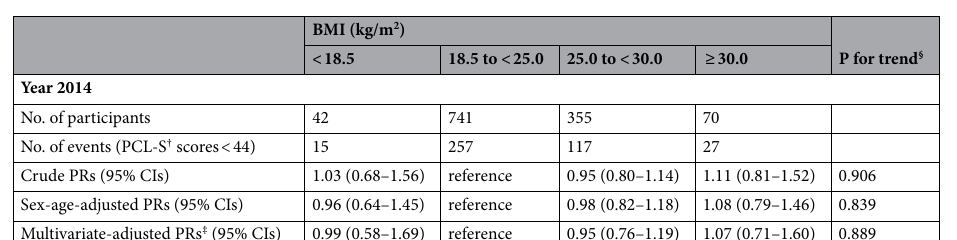
Table 3. PRs † and 95% CIs † of recovery from probable PTSD † according to BMI † in 2012 and 2013. † PR, prevalence ratio; CI, confidence interval; PTSD, post-traumatic stress disorder; BMI, body mass index; PCL-S, Post-traumatic Stress Disorder Checklist-specific. ‡ Multivariate-adjusted PRs were adjusted for sex,